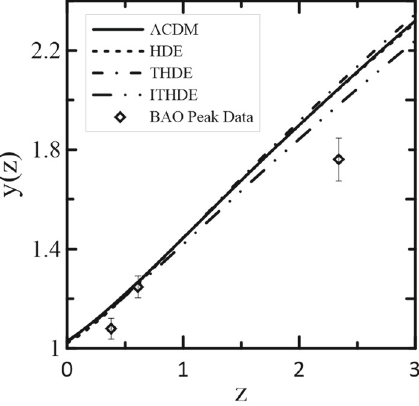
Fig. 4 The evolution of AP test versus redshift for the THDE model with consideration of the future event horizon as IR cutoff. The data used for plotting the trajectories of (cid:2) CDM, HDE, THDE and ITHDE is the CMB + BAO